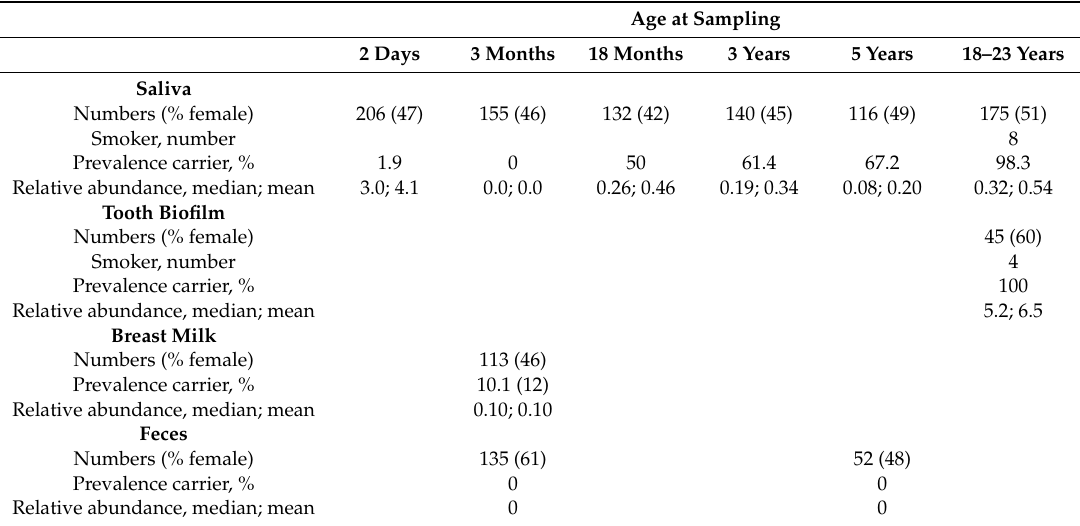
Table 1. Corynebacterium matruchotii detection in saliva, breast milk, and feces by age, and tooth biofilm samples at 18 years of